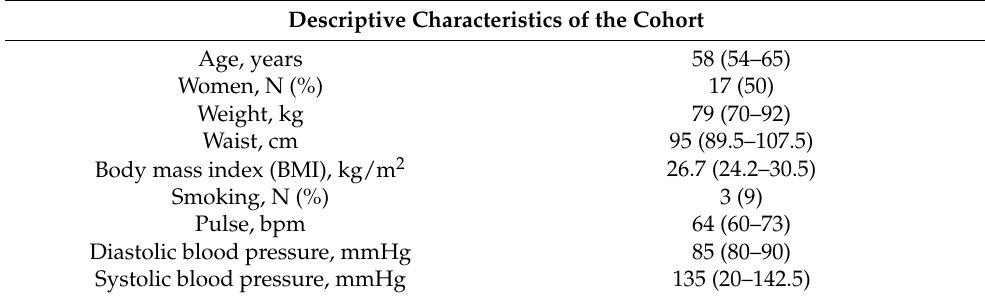
Table 1. Baseline descriptive variables of 33 patients with growth hormone (GH) deficiency. Descriptive Characteristics of the